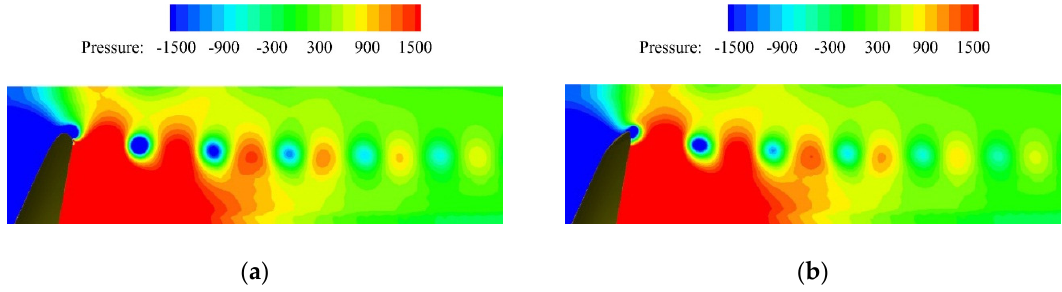
Figure 15. Contours of pressure in the wake of the propeller at J = 0.7: ( a ) benchmark propeller and ( b ) winglet-propeller. ( b ) winglet-propeller.